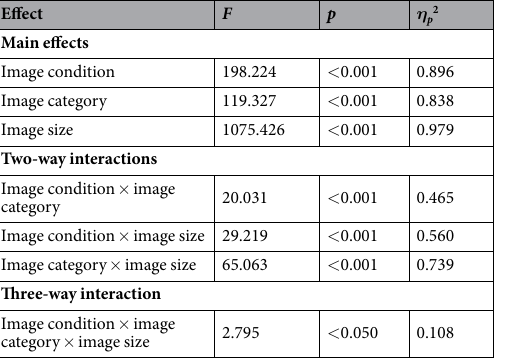
Table 5. Results of the 2 × 3 × 5 (image condition × image category × image size) ANOVA for saccade